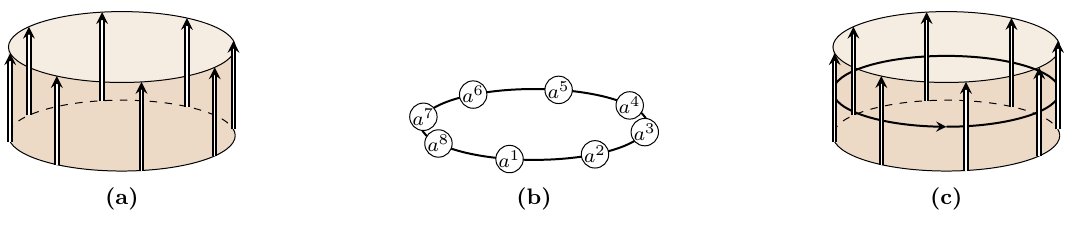
Figure 1 . (a) Double lines in the longitudinal direction of a cylinder. (b) The corresponding quantum spin chain with continuous spin variables. (c) A solid line winding around the cylinder acts on the spin chain by the transfer